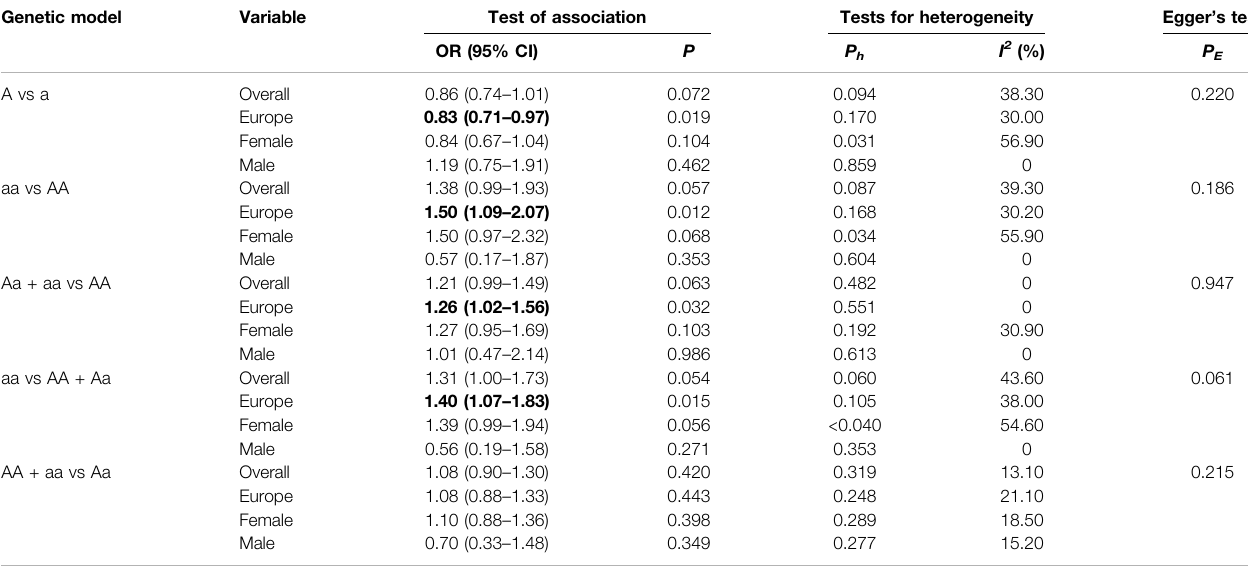
TABLE 8 | Pooled estimates of association of VDR ApaI polymorphism and the risk of osteoporotic fracture. Genetic model Variable